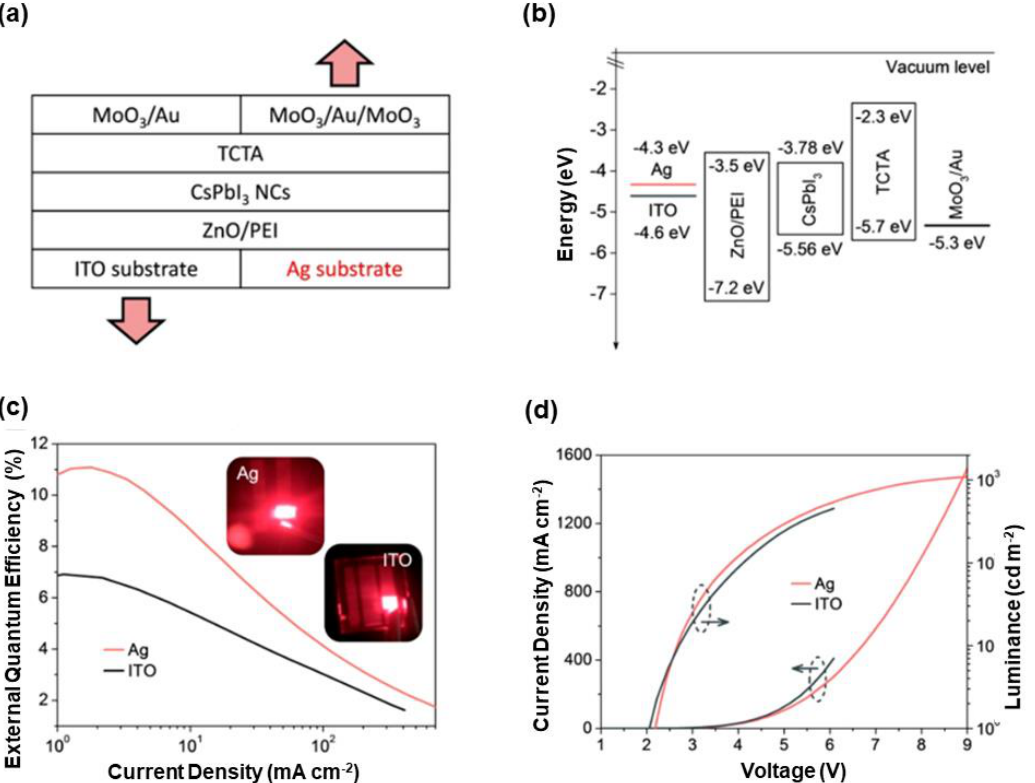
Figure 6. ( a ) Device architectures of PeLEDs with ITO and Ag. Red arrows suggested the transparent side. ( b ) Energy level diagram. ( c ) External quantum efficiency (EQE) of LEDs with Ag and ITO. Inset: photographs of working devices. ( d ) Current density and luminance. Reproduced from reference [270].